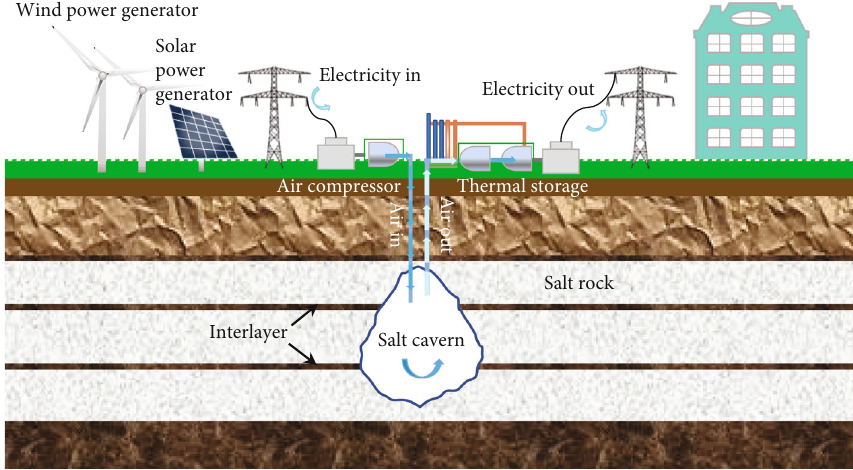
Figure 1: Sketch of salt cavern compressed air energy